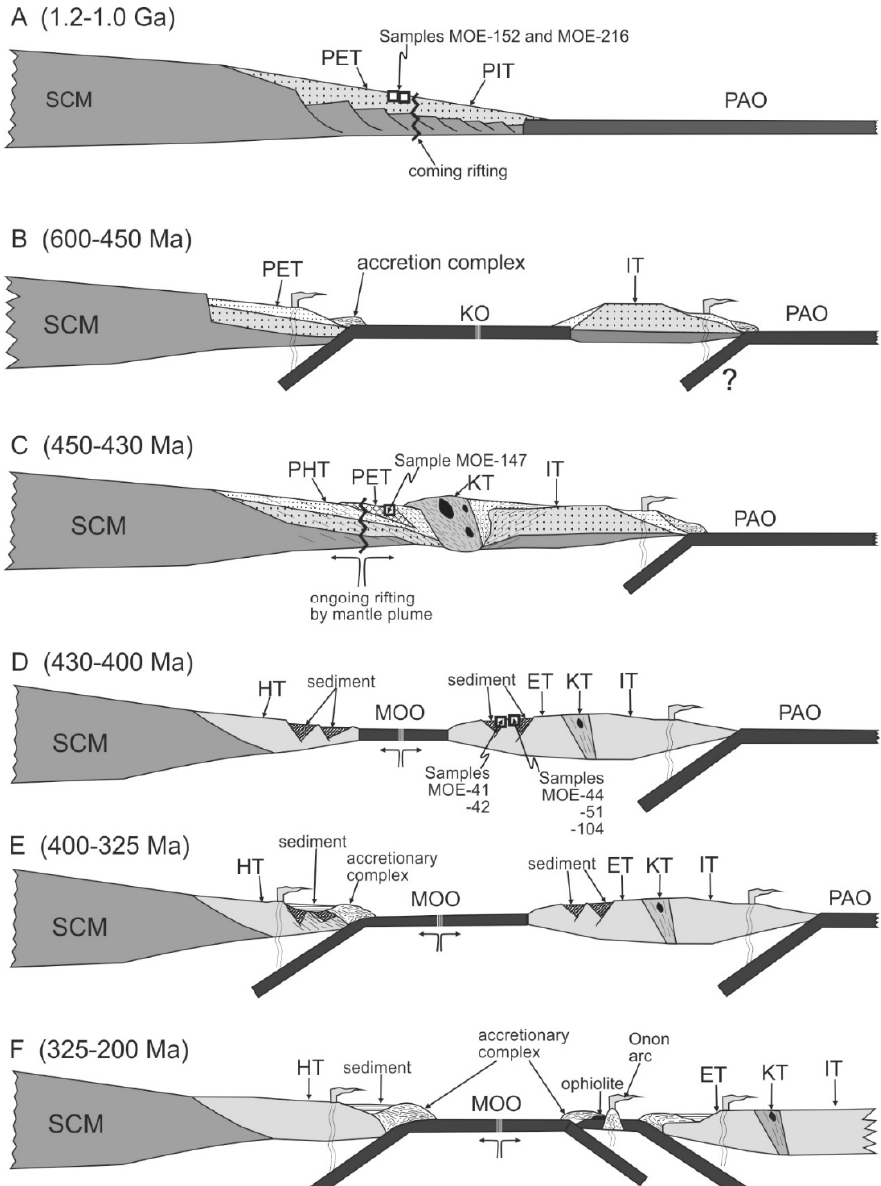
Figure 11. Cartoons showing the evolution of the Ereendavaa terrane and the opening and subduction stages of the Mongol-Okhotsk Ocean. The Mongol–Okhotsk ocean is suggested to have opened within the earlier amalgamated early Paleozoic domain in Mongolia (see text for details). ET—Ereendavaa